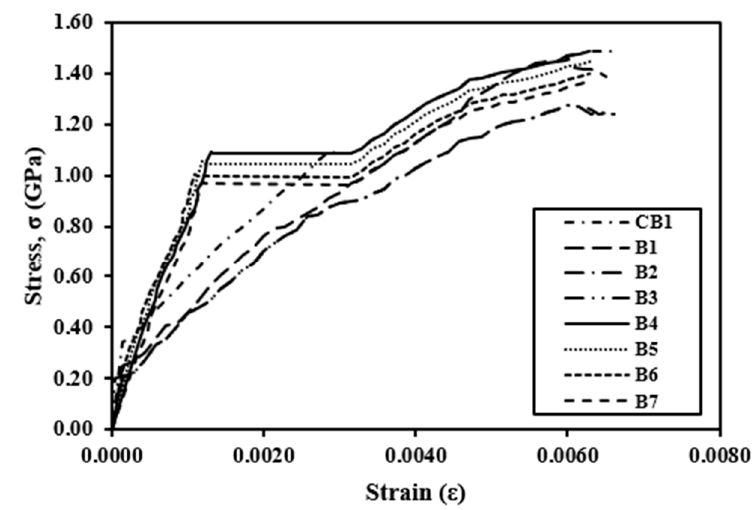
Figure 19. Stress–strain behavior of controlled and strengthened beams.